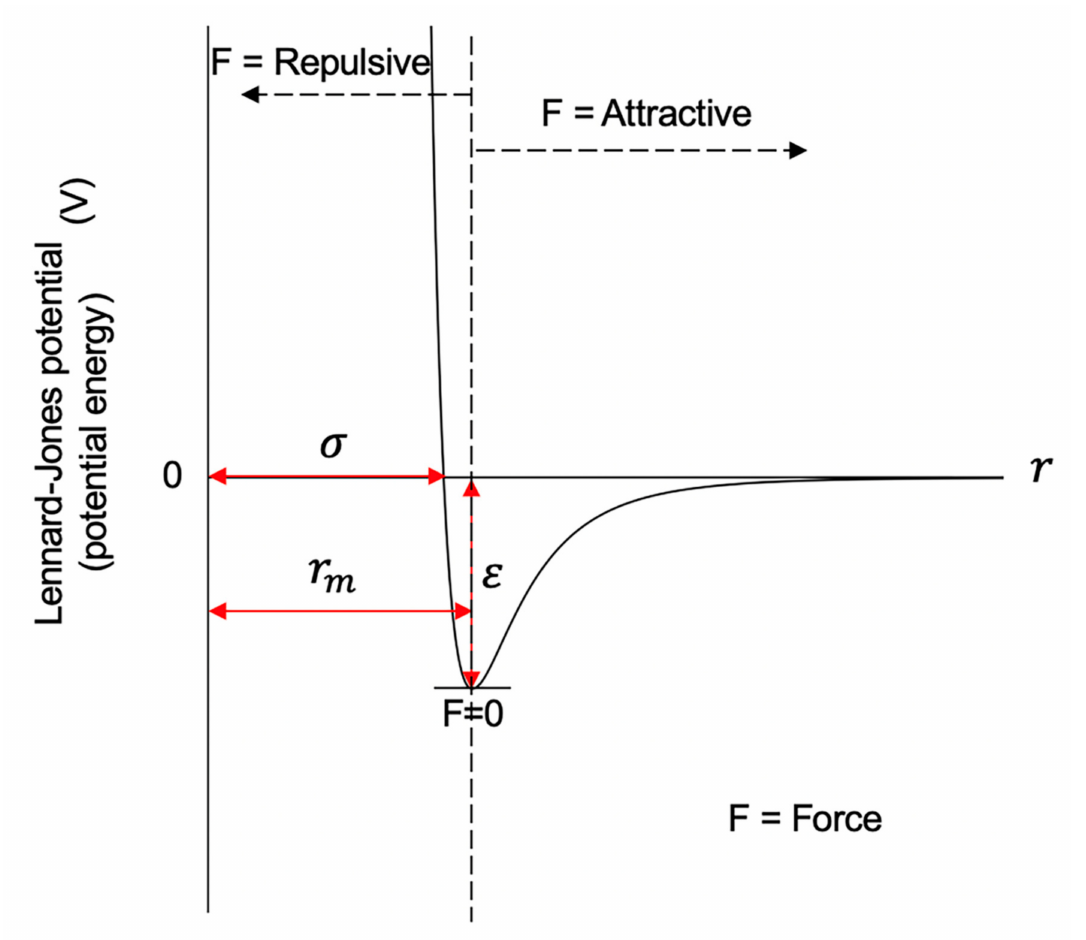
Figure 9. A diagram showing the curve of the Lennard-Jones